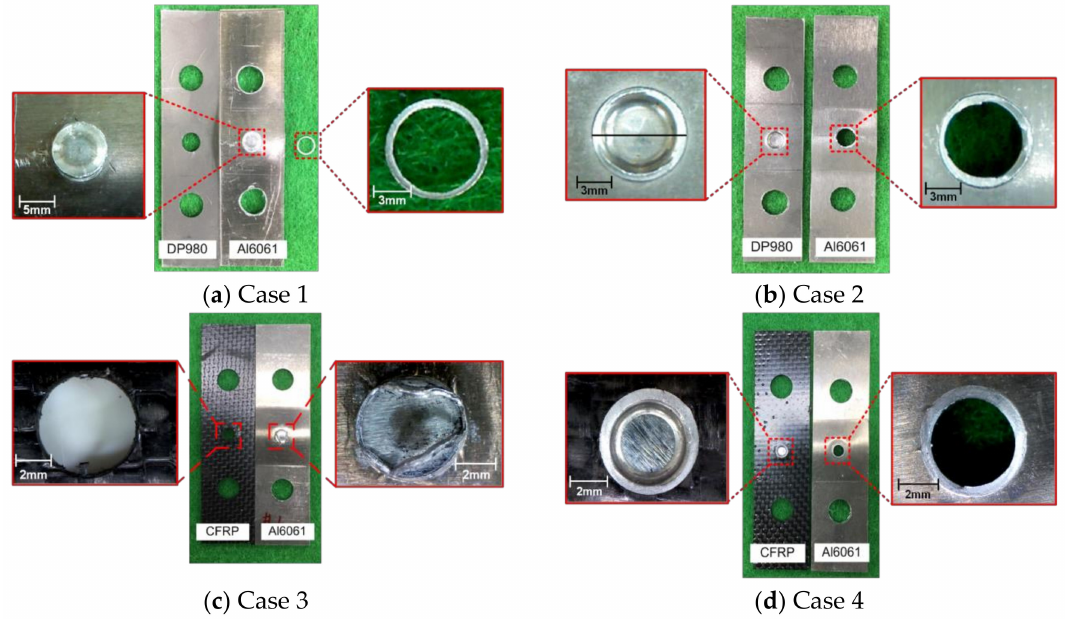
Figure 7. Failure modes of the hole clinched